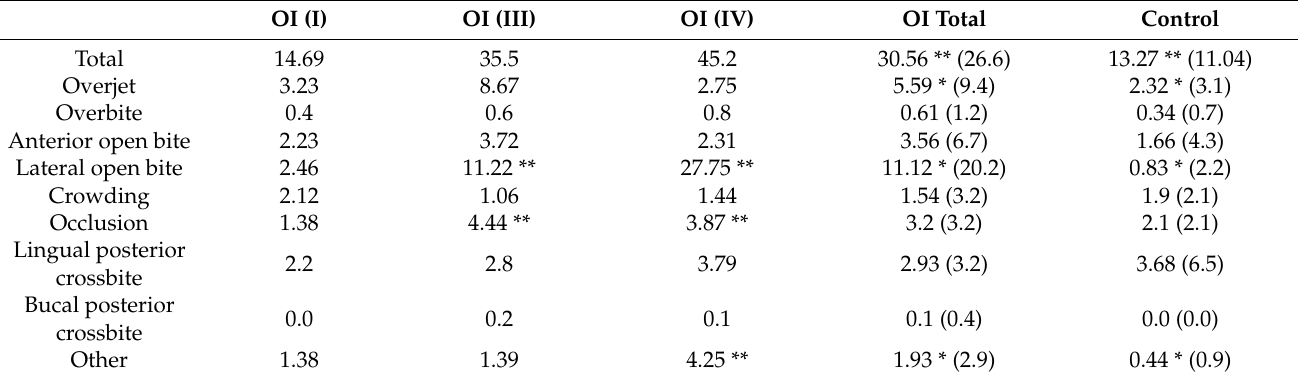
Table 2. Comparative analysis of DI scores between OI group (total) and control group and OI types. Discrepancy index (DI); Osteogenesis Imperfecta (OI).